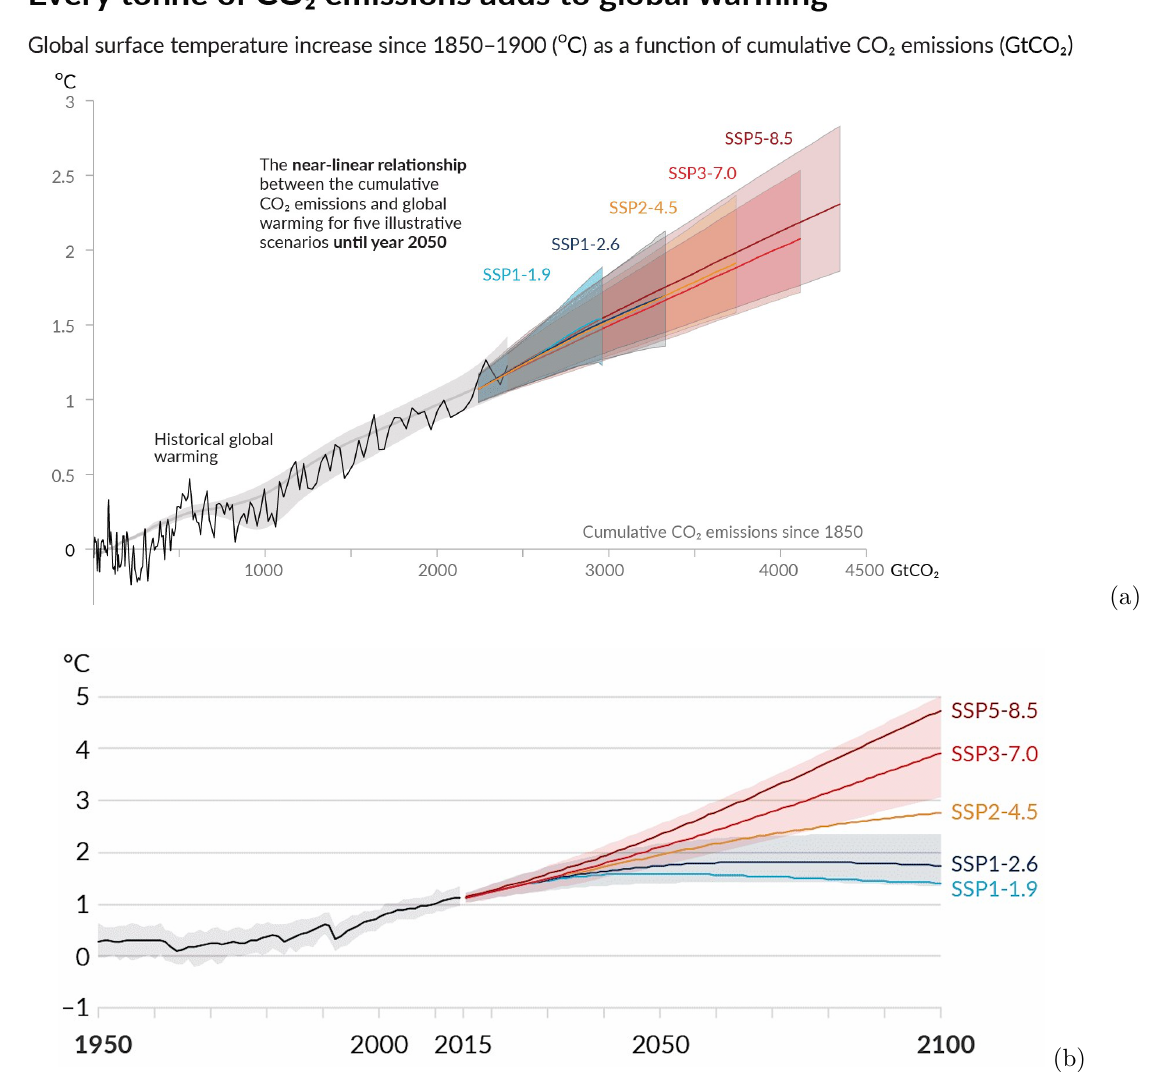
Figure 3. Pathway dependent global climate futures: (a) Near-linear linear relationship between cumulative emissions and global surface temperature (b) Global surface temperature changes in ◦ C relative to 1850-1900